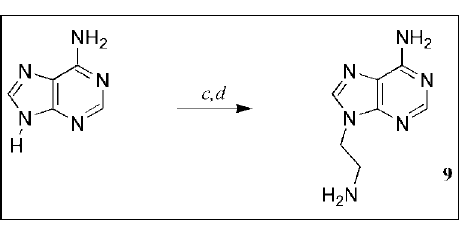
Table 1 - Inhibition of adenosine transport by T. equiperdum in the presence of inosine and in vitro toxicity of the same